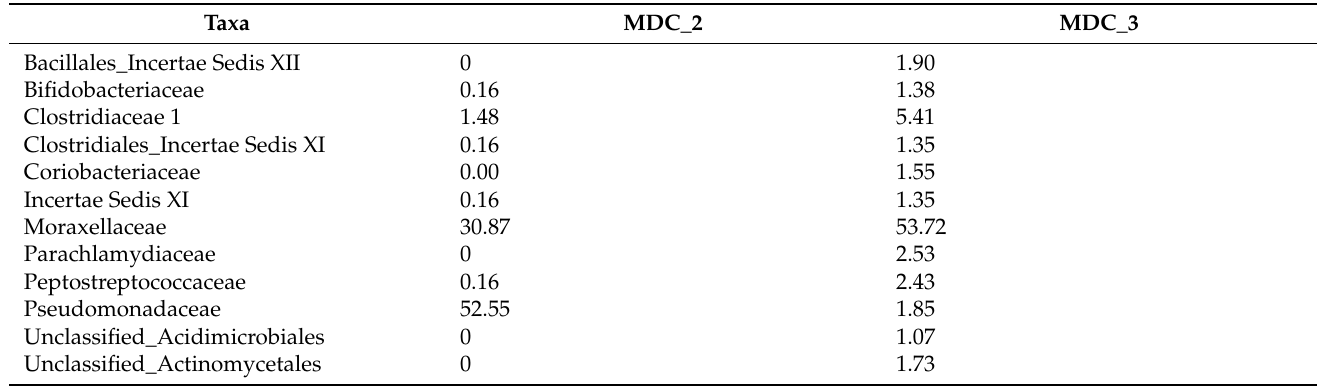
Table 1. Microbial taxa (families) in MDC_2 and MDC_3.